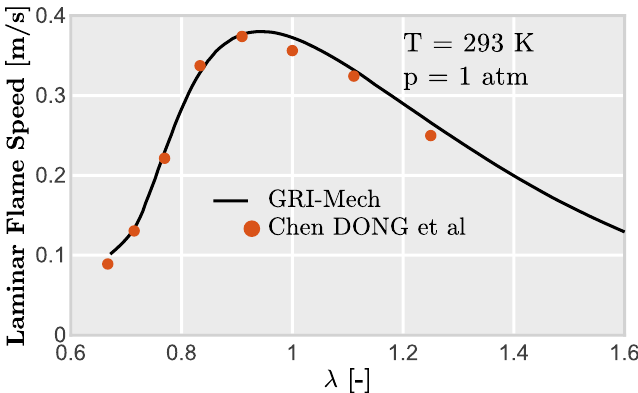
Figure 2. Validation of CNG laminar flame speed for different air-to-fuel